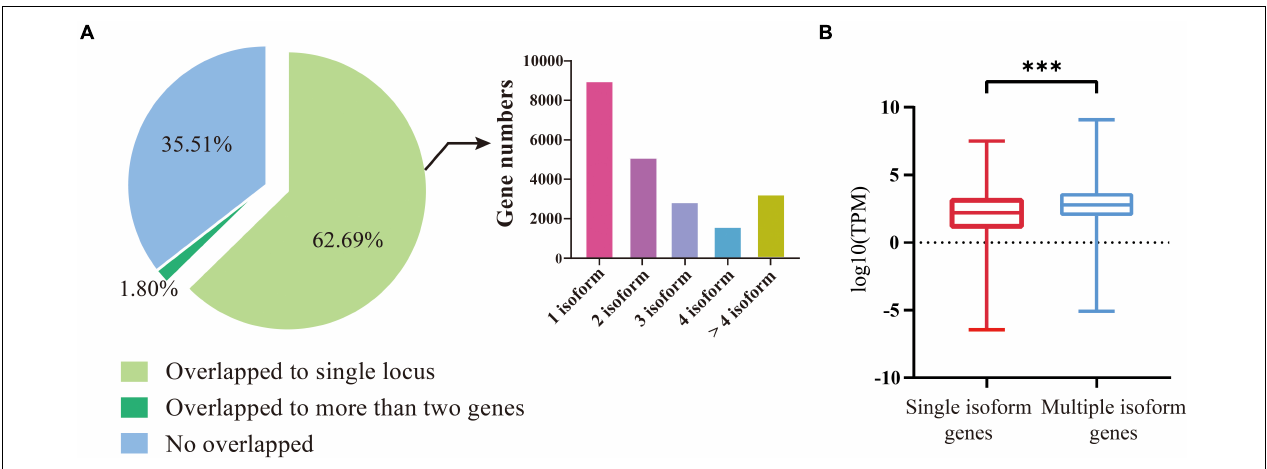
FIGURE 1 | Identification and characterization of isoforms and the genes involved. (A) Left, division of the FLNC isoforms based on their genome mapping status. The percentages of isoforms in each group are depicted in the pie chart. Right, the distribution of genes covered by different number of isoforms. (B) The expression levels of genes covered by single isoforms and multiple isoforms. The three stars represent P -value < 0.001.